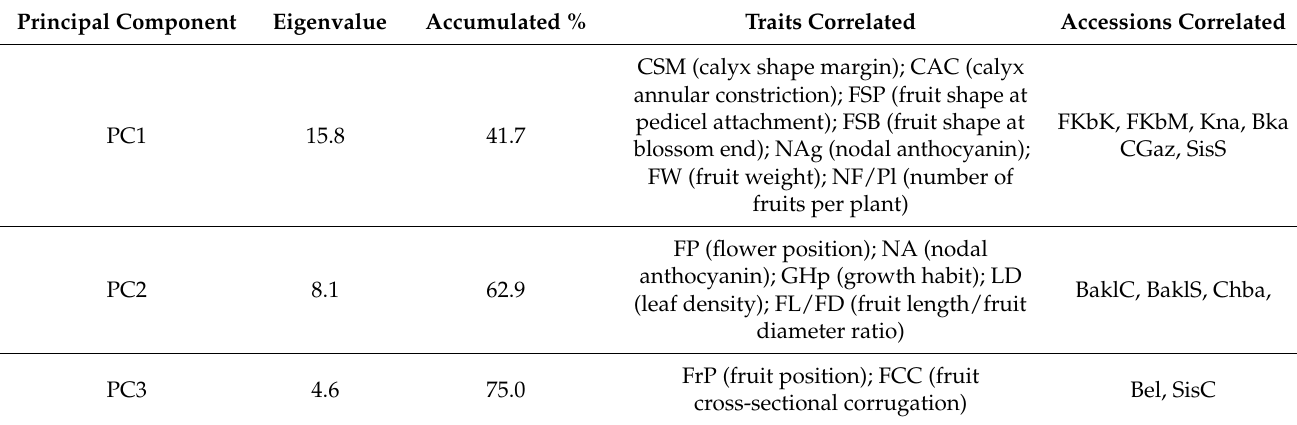
Table 4. Variance estimates (eigenvalues) for the 25 evaluated traits in the eleven Tunisian chili pepper accessions. Principal